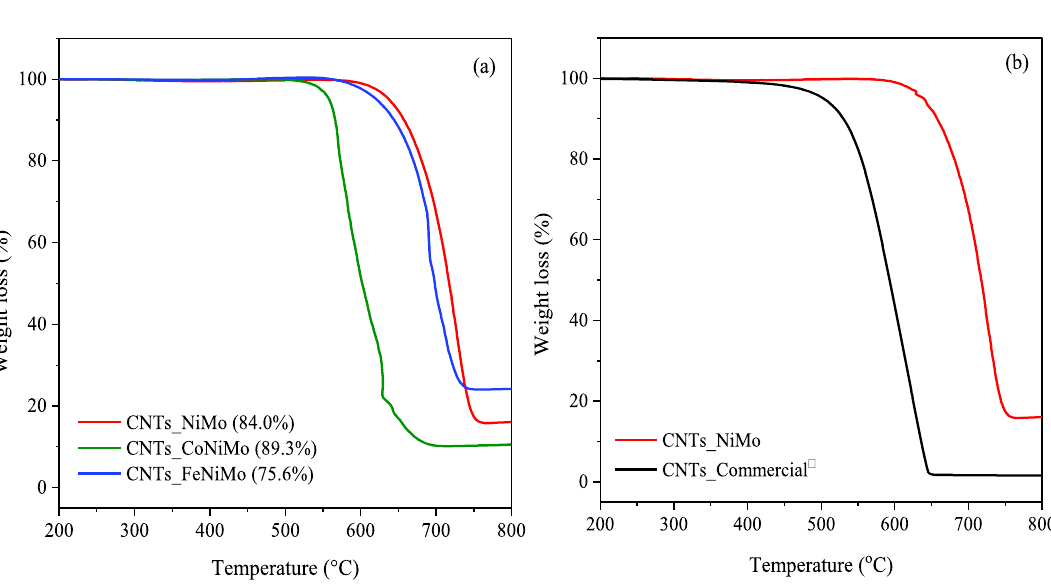
Figure 8. TGA curves of CNTs synthesized over spent catalysts ( a ) in this study ( b ) compared to commercial CNTs (Bayer ®